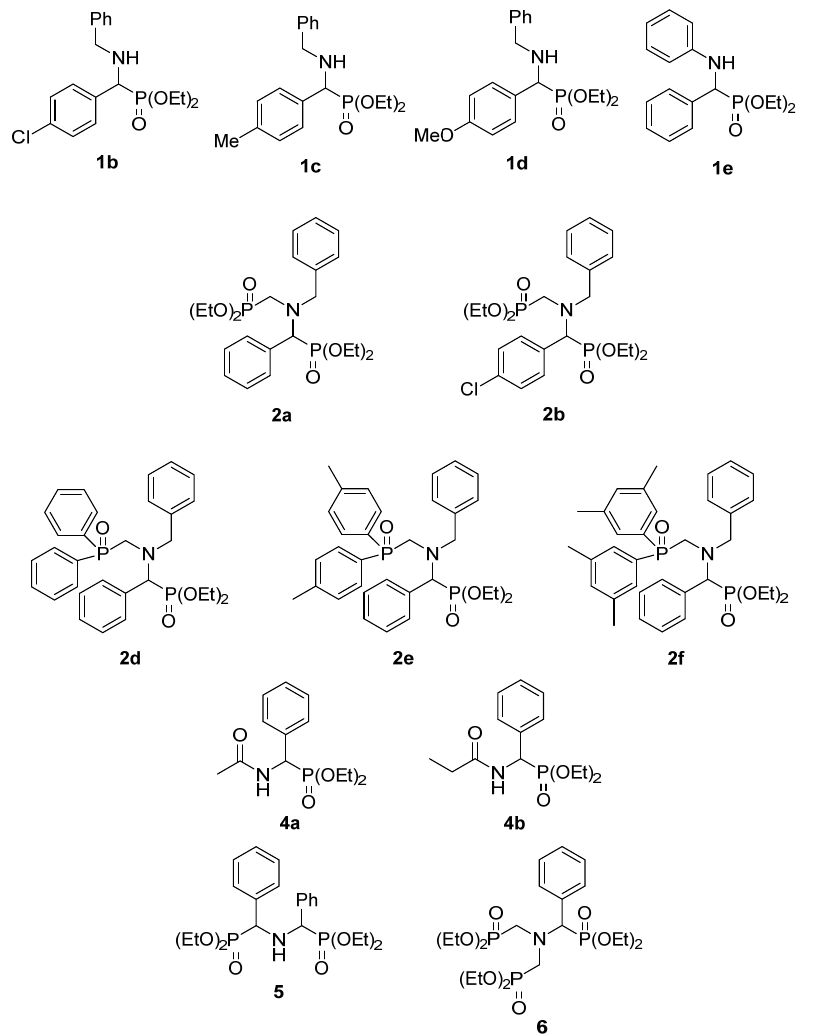
Figure 1. Molecule library of the compounds subjected to bioactivity screening. Table 1. In vitro cytostatic e ff ect of α -aminophosphonic derivatives on human tumor cell lines.